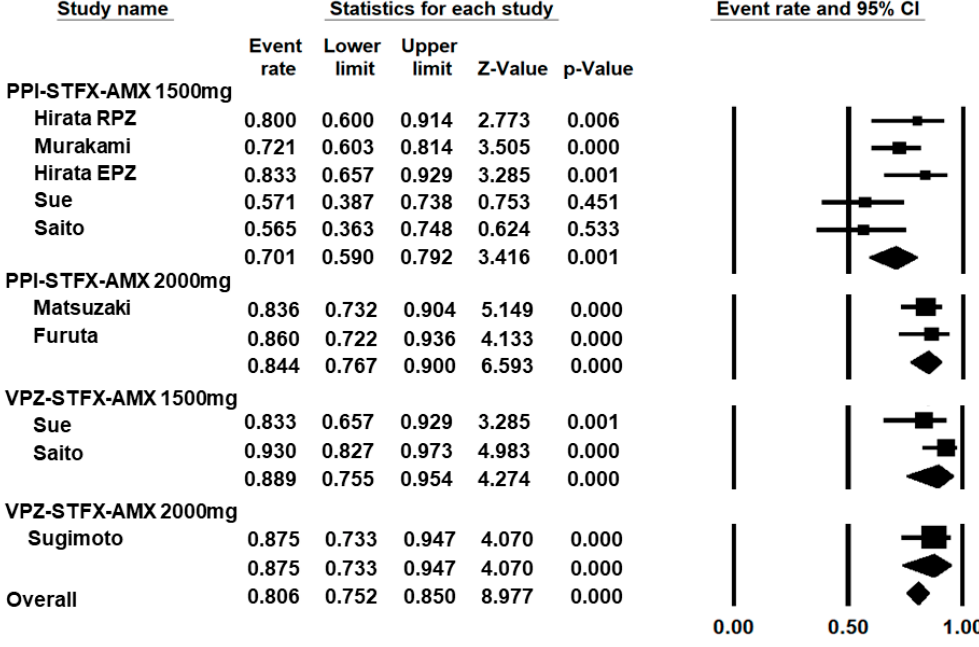
Figure 3. Forest plot of the pooled odds ratio (OR) with 95% confidence intervals (CI) of successful eradication when using regimens of vonoprazan–sitafloxacin–amoxicillin and PPI–sitafloxacin–amoxicillin. ( A ) Per-protocol analysis. ( B ) Inten- tion-to-treat analysis.